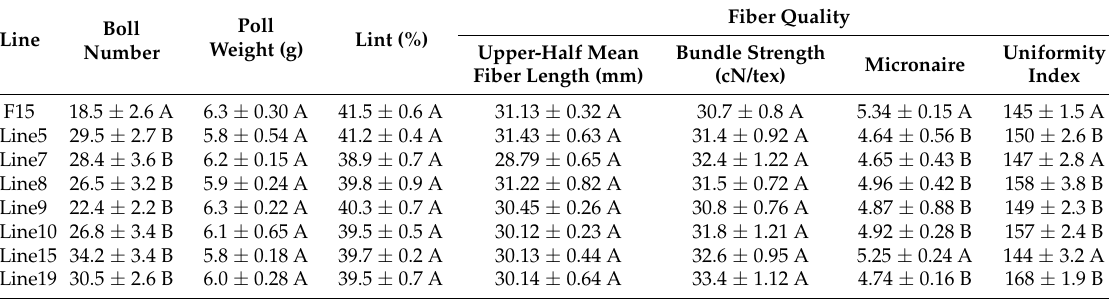
Table 2. Cotton yield and fiber quality of transgenic cotton expressing HaHR3